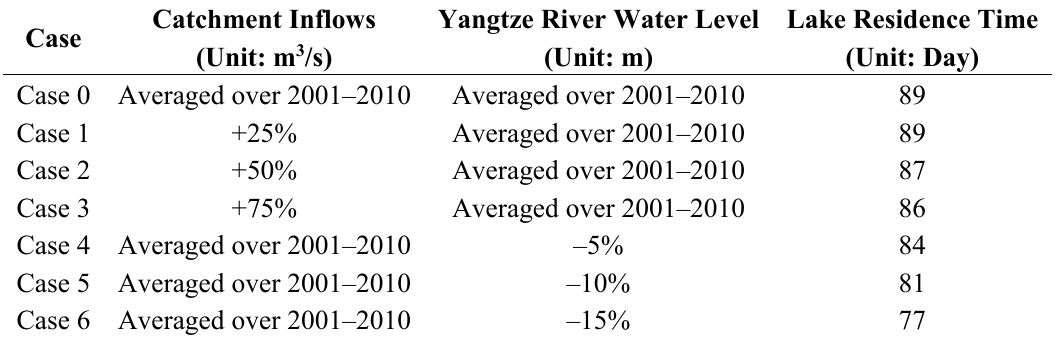
Table 2. Cases examined at model boundaries to evaluate the effects of the catchment rivers and the Yangtze River on lake mean residence